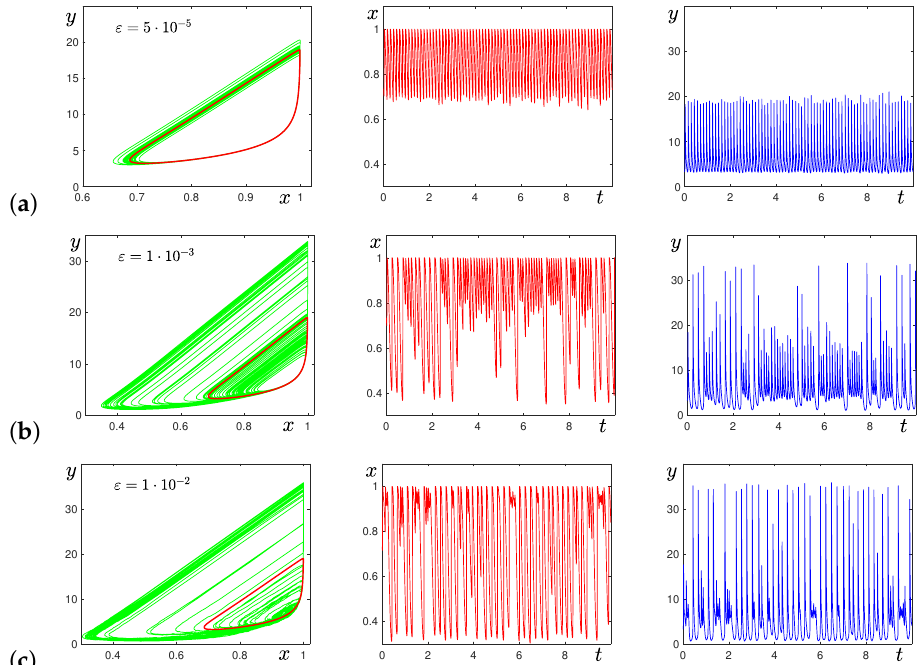
Figure 3. Phase trajectories and time series of system (2) with D = 0.097 for ( a ) ε = 5 × 10 − 5 , ( b ) ε = 1 × 10 − 3 , and ( c ) ε = 1 × 10 − 2